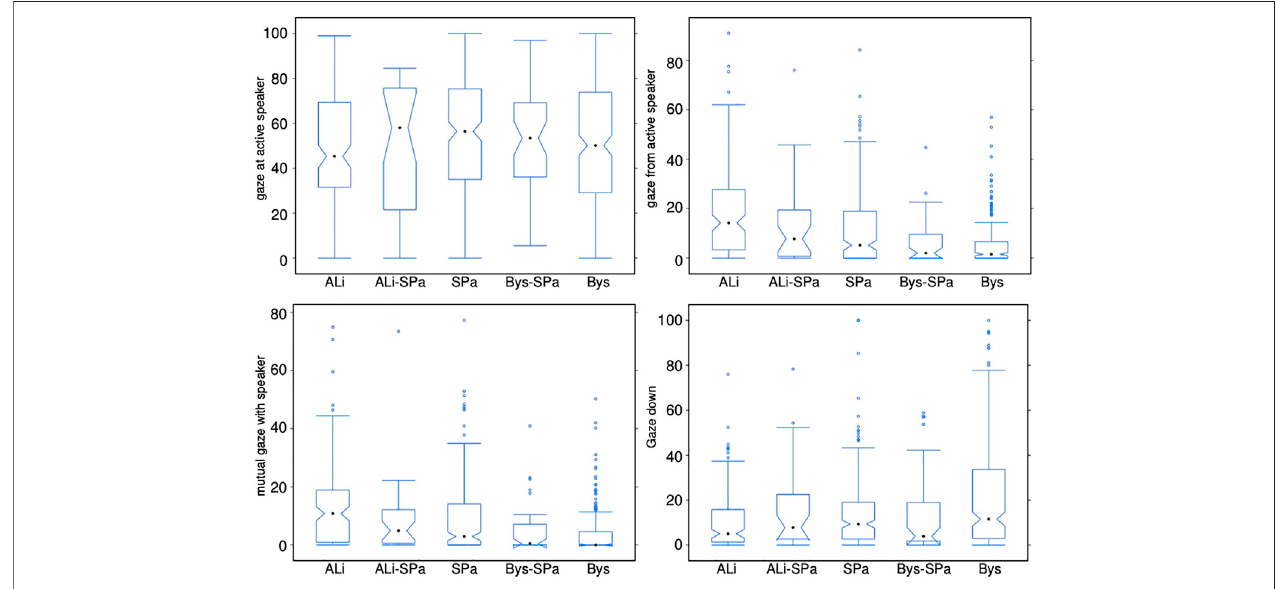
FIGURE 2 | Eye gaze patterns between the various listener categories and the speaker as well as downwards. See section 4.3.4 for the de fi nition of these measures.